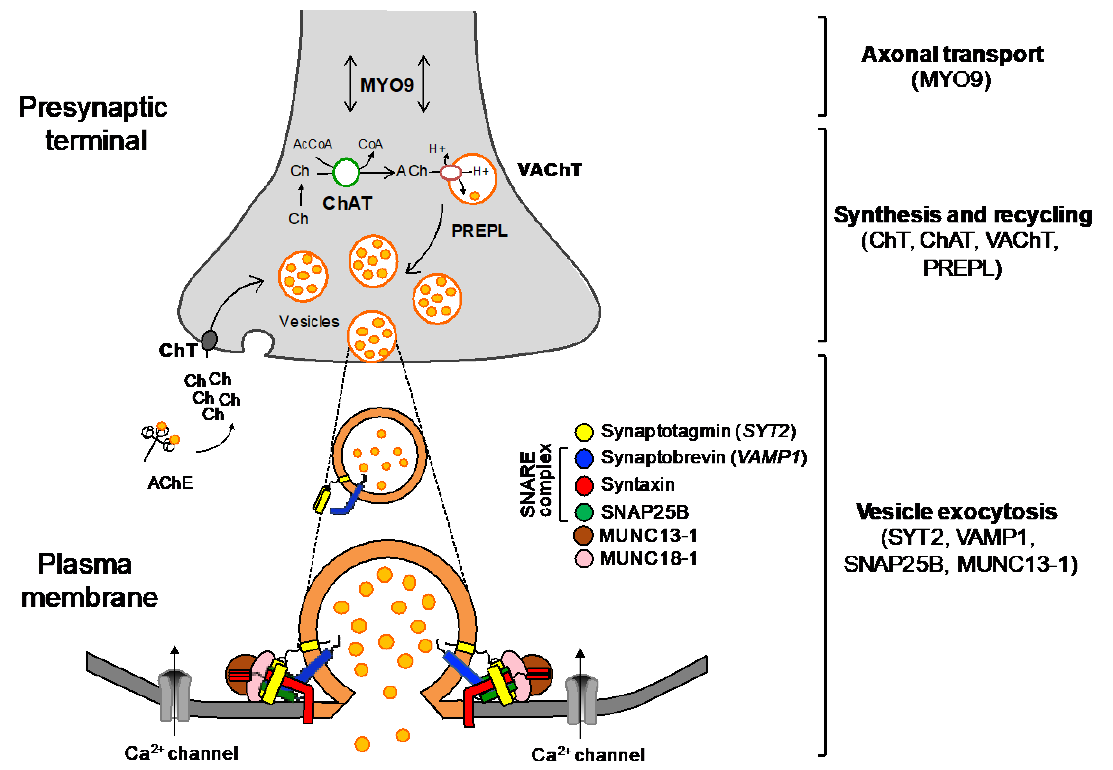
Figure 3. Schematic representation of the nerve terminal and the main molecules involved in presynaptic CMS. In the synaptic cleft, acetylcholinesterase (AChE) breaks down acetylcholine (ACh) into acetate and choline (Ch), which is uptaken by the sodium-dependent high-affinity choline transporter 1 (ChT) to the presynaptic terminal. The enzyme choline acetyltransferase (ChAT) catalyses the synthesis of ACh from acetyl coenzyme A (AcCoA) and choline, and the vesicular acetylcholine transporter (VAChT) loads ACh into synaptic vesicles. PREPL encodes a protein that is meant to act as an effector of the clathrin-associated adaptor protein 1 in the trafficking of VAChT [7]. The synaptic vesicles accumulate adjacent to the nerve terminal ready for exocytosis. Upon the arrival of an action potential, voltage-dependent Ca 2+ channels open and the influx of Ca 2+ cause the fusion of vesicles to the plasma membrane through the soluble N -ethylmaleimide-sensitive factor attachment protein receptor (SNARE) complex (synaptobrevin, syntaxin, and SNAP25B) and the Ca 2+ sensor, synaptotagmin. Additionally, MUNC 13-1 and MUNC 18-1 (syntaxin-binding protein 1) take part in the assembly and disassembly of the complex through mechanisms still not fully understood [8]. Myosin-IX A is believed to be involved in axonal transport (two directions arrow). Adapted from [9].